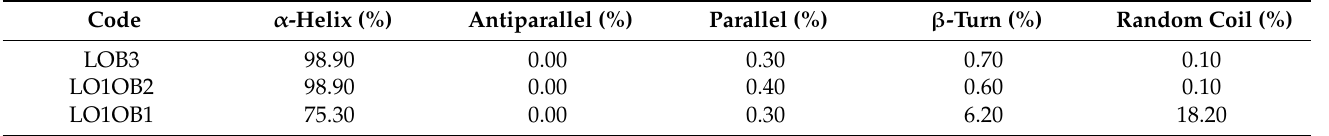
Table 3. Protein secondary structure estimates for LOs of CD spectra (260–200 nm) in an aqueous- DMSO